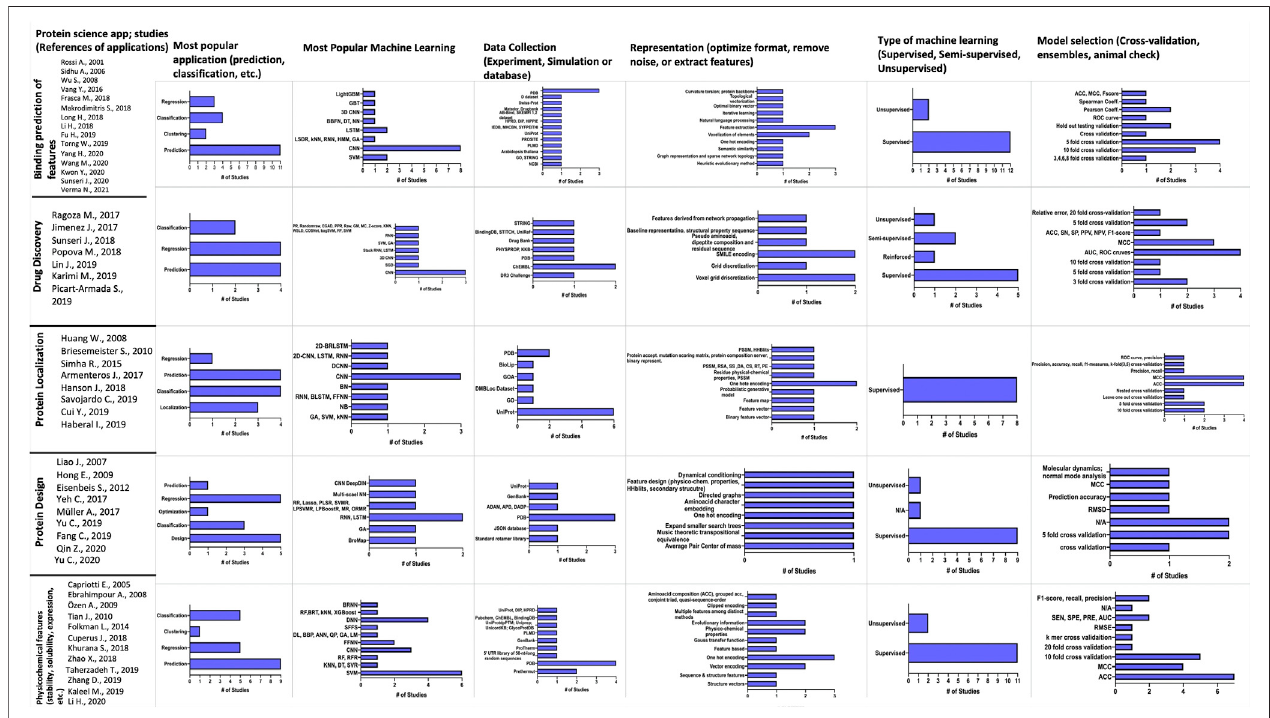
Frontiers in Bioengineering and Biotechnology |